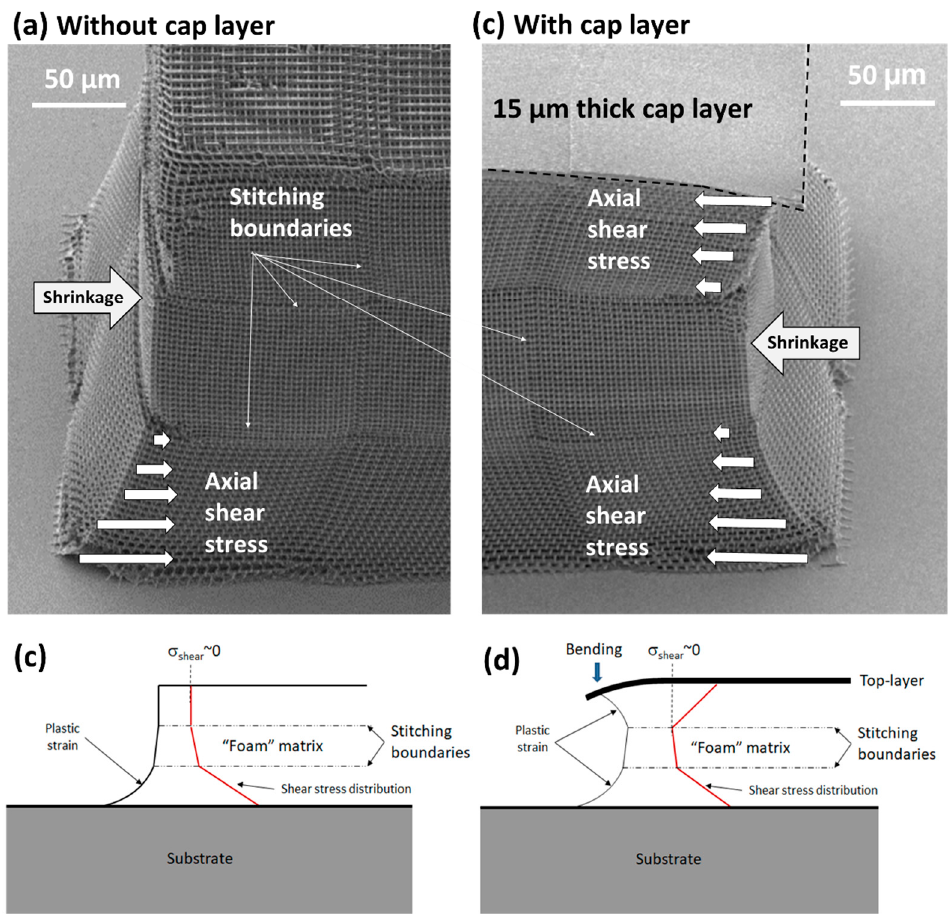
Figure 10. Details of the structural deformation of IP-Dip foam rods, specifically showing the regions within the dashed boxes in Figure 8. The SEM images show the ends of the rod ( a ) without and ( b ) with a 15-um-thick fully dense cap layer. Resin shrinkage during development and drying produced residual axial shear stresses and associated plastic strains in both the foam only and the foam with top cap, as shown schematically in ( c , d ) and also indicated in the SEM images; the arrow lengths are notional representations of the relative magnitude of the axial shear stresses.